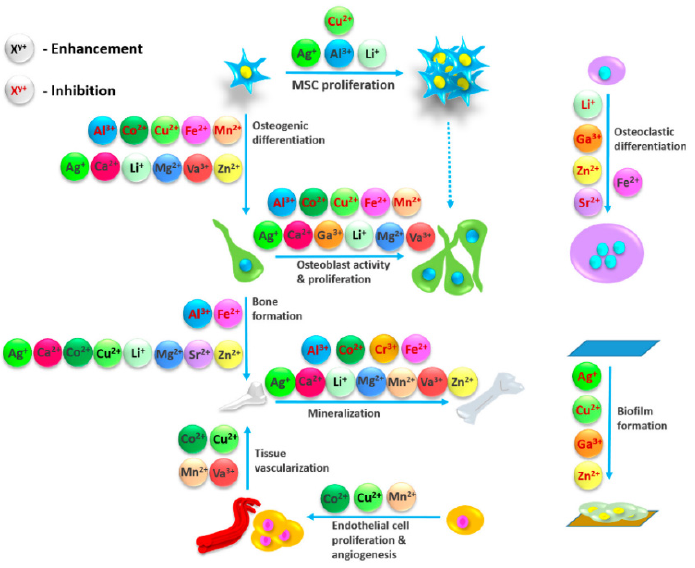
Figure 1. Effect of different ions in bone regeneration processes. Obtained from the reference [13].